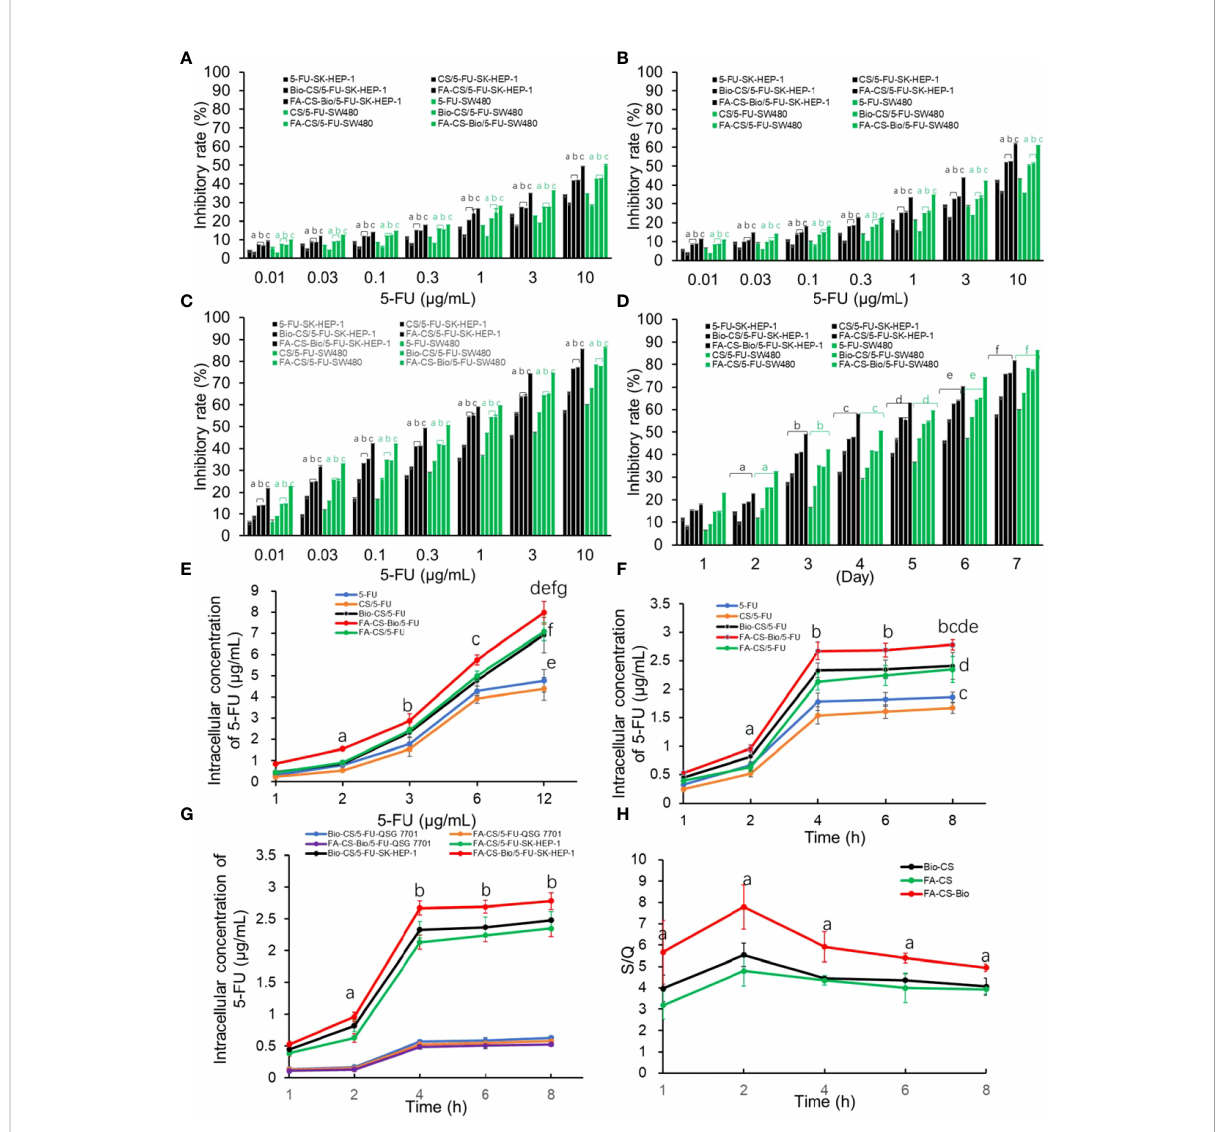
FIGURE 2 Effects of different 5-FU nanoformulations on the proliferation and intracellular 5-FU concentration of liver cancer cells (A) After 24 hours of culture, the effects of various 5-FU nanoformulations on tumor cell proliferation Note: compared with 5-FU, a p < 0.01; compared with CS/5-FU, b p < 0.01; compared with FA-CS/5-FU or Bio-CS/5-FU, c p <0.01. (B) The effects of various 5-FU nanoformulations on tumor cell proliferation after 48 hours of culture. Note: compared with 5-FU, a p <0.01; compared with CS/5-FU, b p <0.01; compared with FA-CS/5-FU or Bio-CS/5-FU, c p <0.01. (C) The effect of different 5-FU nano-formulations on tumor cell proliferation after 72 hours of culture. Note: compared with 5-FU, a p <0.01; compared with CS/5-FU, b p <0.01; compared with FA-CS/5-FU or Bio-CS/5-FU dosage form, c p <0.01. (D) The effect of different 5-FU nano-formulations on the proliferation of tumor cells cultured for 1 – 7 days at a 5-FU concentration of 0.3 g/mL. Note: compared with cultured 1 d, a p <0.01; compared with cultured 2 d, b p <0.01; compared with cultured 3 d, c p < 0.01; compared with cultured 4 d, d p < 0.01; compared with cultured 5 d, e p <0.01; compared with cultured 6 d, e p < 0.01; compared with cultured 7 d, f p <0.01. (E) The effect of nanoformulations with different 5-FU concentrations on the intracellular drug concentration of liver cancer cells. Note: compared with 1 m g/mL, a p <0.01; compared with 2 m g/mL, b p < 0.01; compared with 3 m g/mL, c p <0.01; compared with 6 m g/mL, d p <0.01; compared with CS/5-FU, e p < 0.01; compared with 5- FU, f p < 0.01; compared with FA-CS/5-FU or Bio-CS/5-FU, g p < 0.01. (F) Effects of different 5-FU nanoformulations on the intracellular drug concentration of hepatoma cells after culturing for 1-8 h Note: compared with 1 h, a p < 0.01; compared with 2 h, b p < 0.01; compared with CS/5- FU, c p < 0.01; compared with 5-FU, d p < 0.01; compared with FA-CS/5-FU or Bio-CS/5-FU comparison, e p < 0.01. (G) The effects of various 5-FU nanoformulations on drug concentration in hepatoma cells and hepatocytes cultured for 1 – 8 h Note: compared with 1 h, a p < 0.01; compared with 2 h, b p < 0.01. (H) The impact of different 5-FU nanoformulations on the S/Q ratio after culturing for 1-8 h. Note: compared with FA-CS or Bio-CS, a p <